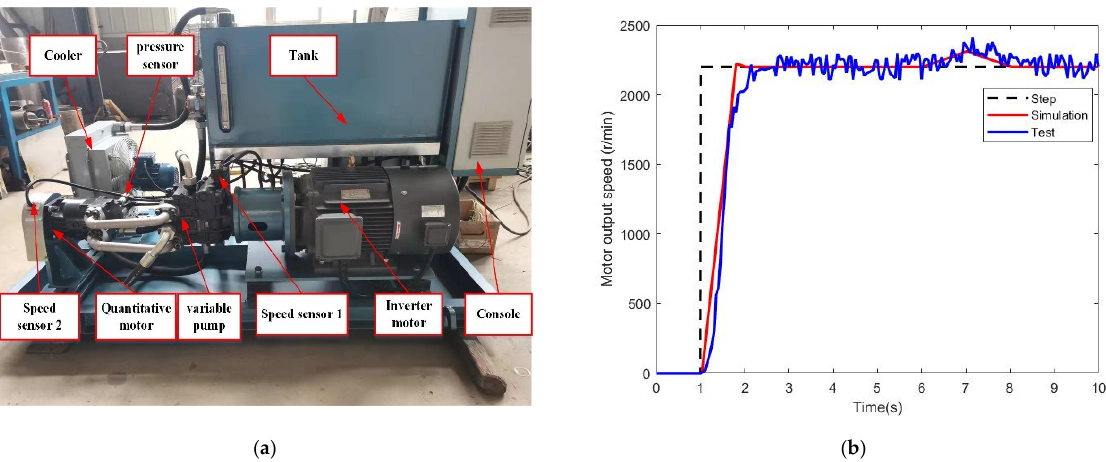
Figure 11. Pump-Motor test verification. ( a ) Variable pump-fixed motor hydraulic test platform; ( b ) Step experiment verification.